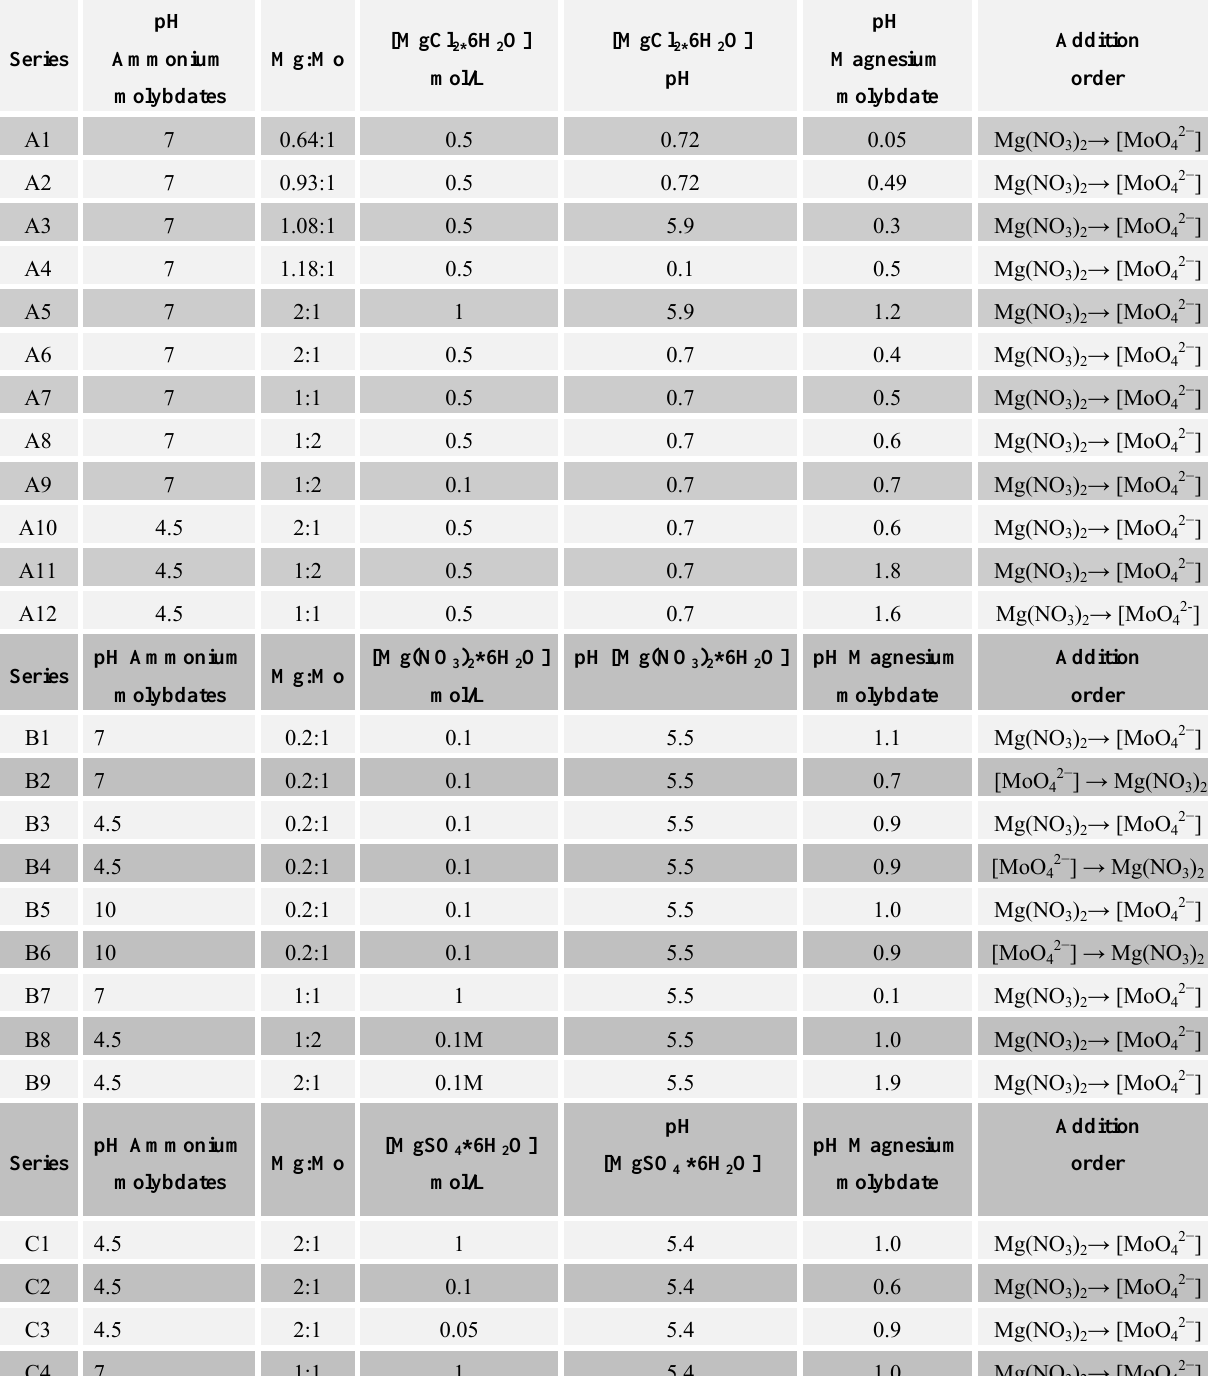
Table 2. Preparation conditions of magnesium molybdate